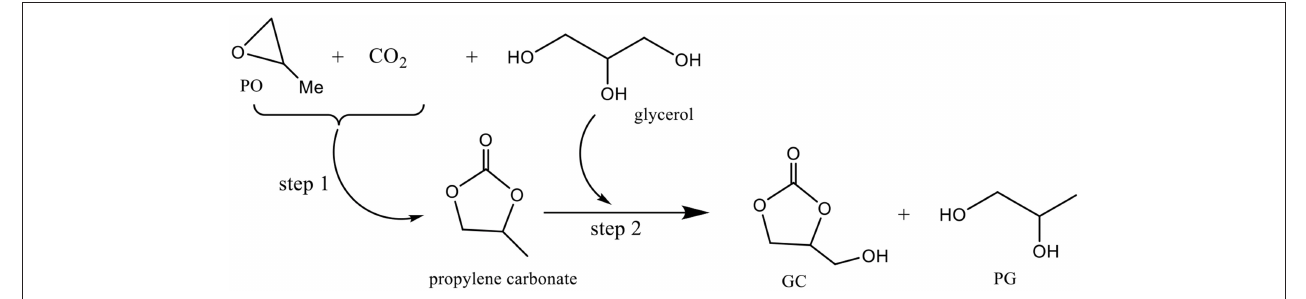
FIGURE 5 | Reaction of glycerol in presence of CO 2 and PO.